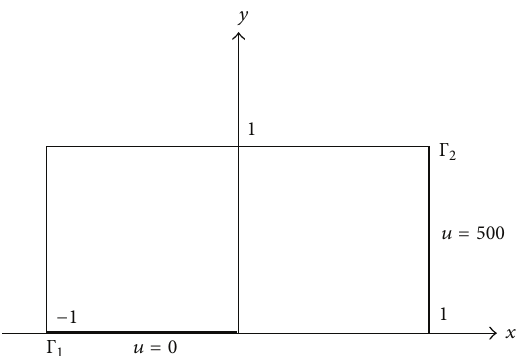
Figure 1: The domain for the Motz problem. Essential boundary conditions are imposed on Γ 1 and Γ 2 ; otherwise Neumann boundary condition is